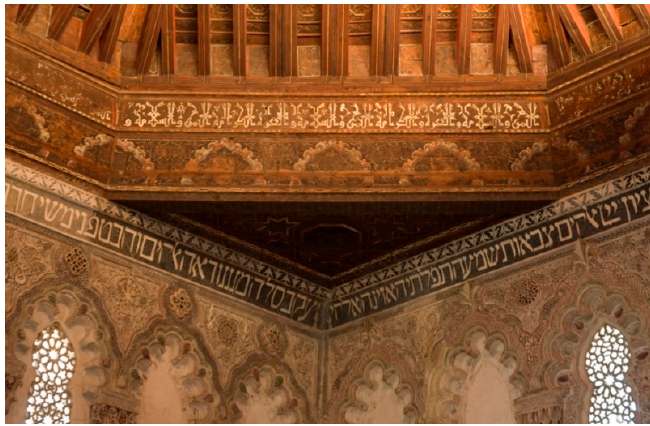
Figure 29. Arabic inscription frieze around the prayer room of El Tránsito Synagogue of Toledo. Author’s photo.